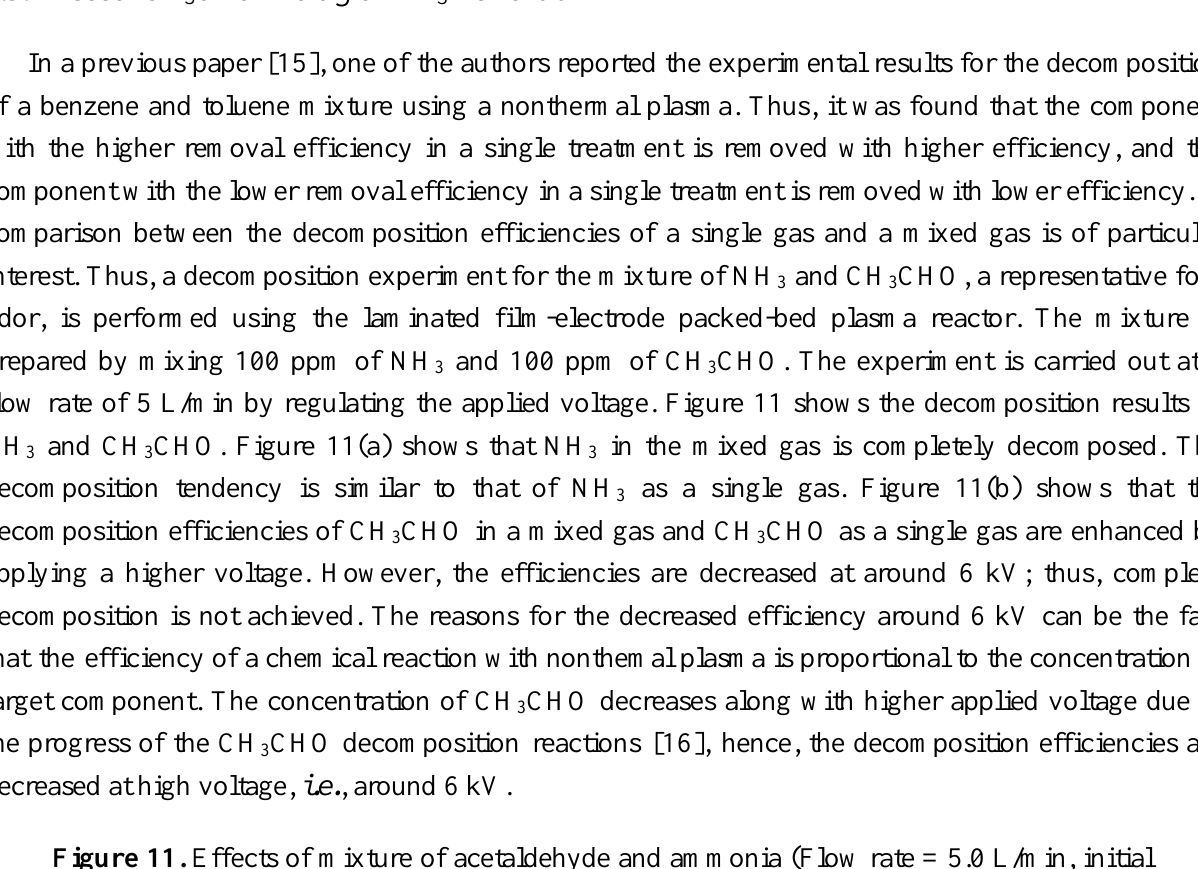
Figure 11. Effects of mixture of acetaldehyde and ammonia (Flow rate = 5.0 L/min, initial concentration = 100 ppm, laminated film-electrode packed-bed plasma reactor). (a) NH3 decomposition; (b) CH3CHO decomposition.